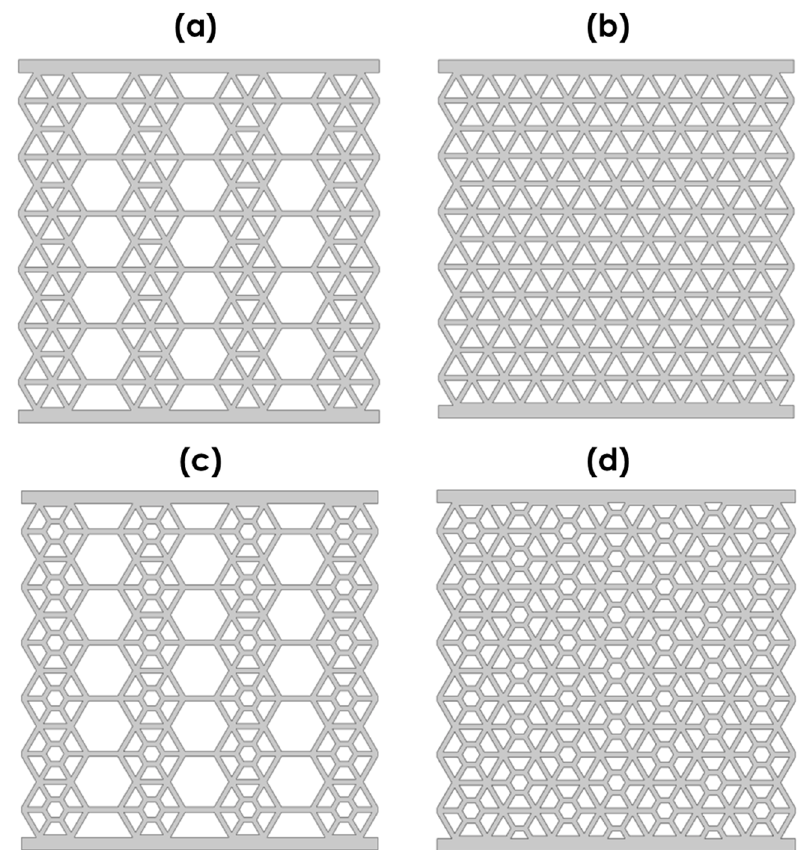
Figure 2. ( a ) Triangularly reinforced pseudo-composite (TRPC) structure with pseudo-fibres in line with the axis of loading ( b ) a full system of triangular reinforcement within the hexagonal (pseudo-matrix) system (c.f. Figure 1), ( c ) scaled hexagonally reinforced pseudo-composite (SHRPC) structure with pseudo-fibres in line with the axis of loading ( d ) a full system of scaled hexagonal reinforcement within the original hexagonal (pseudo-matrix) system (c.f. Figure 1).